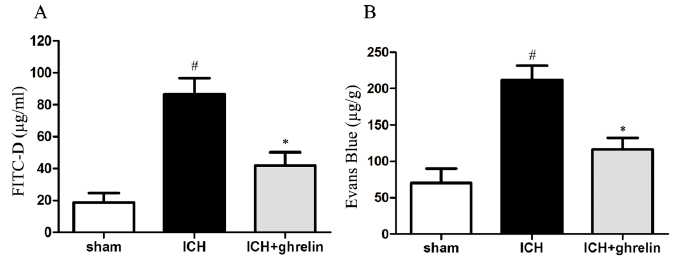
Figure 1. Ghrelin attenuated intestinal mucosal injury after intracerebral hemorrhage (ICH). ( A ) The sham group showed nearly intact mucosa at the histomorphometric level. Scale bar = 100 µm; ( B ) The ICH group presented severe lifting of epithelial cells, thickened and shortened villi, fusion of adjacent villi, and naked lamina propria at the histomorphometric level; ( C ) Less lifting of epithelial cells, thinner and longer villi, less fusion of adjacent villi and naked lamina propria were observed in the ghrelin-treated group at the histomorphometric level; ( D ) The sham group showed smooth-surfaced, orderly arranged villi with few secretions at the ultrastructural level. Scale bar = 300 µm; ( E ) ICH induced marked ultrastructural changes, including increased secretions, irregularly arranged, thickened, sparse, and surface-ruptured villi; and ( F ) Less secretions and more intact villi were observed in the ICH + ghrelin group at the ultrastructural level. n = 4 per group.